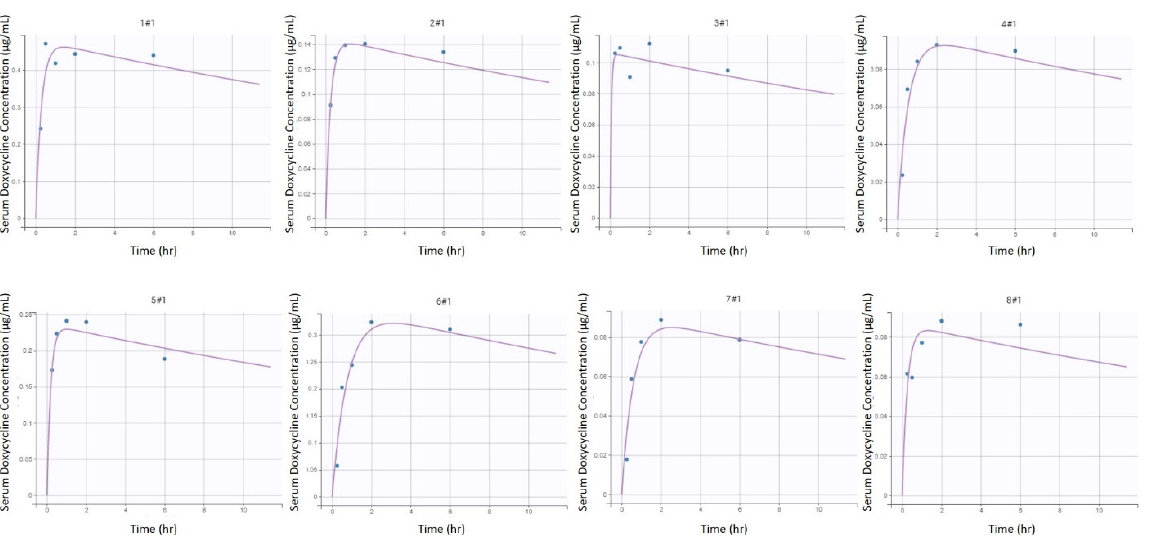
model ( n = 8). Scatter plot of observed (blue dot) and predicted (dashed purple line) individual concentration vs. time after